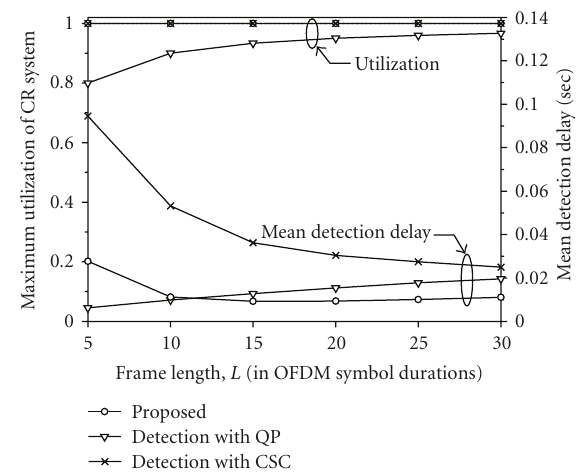
Figure 5: Maximum utilization of CR system and mean detection delay according to L (QP: quiet